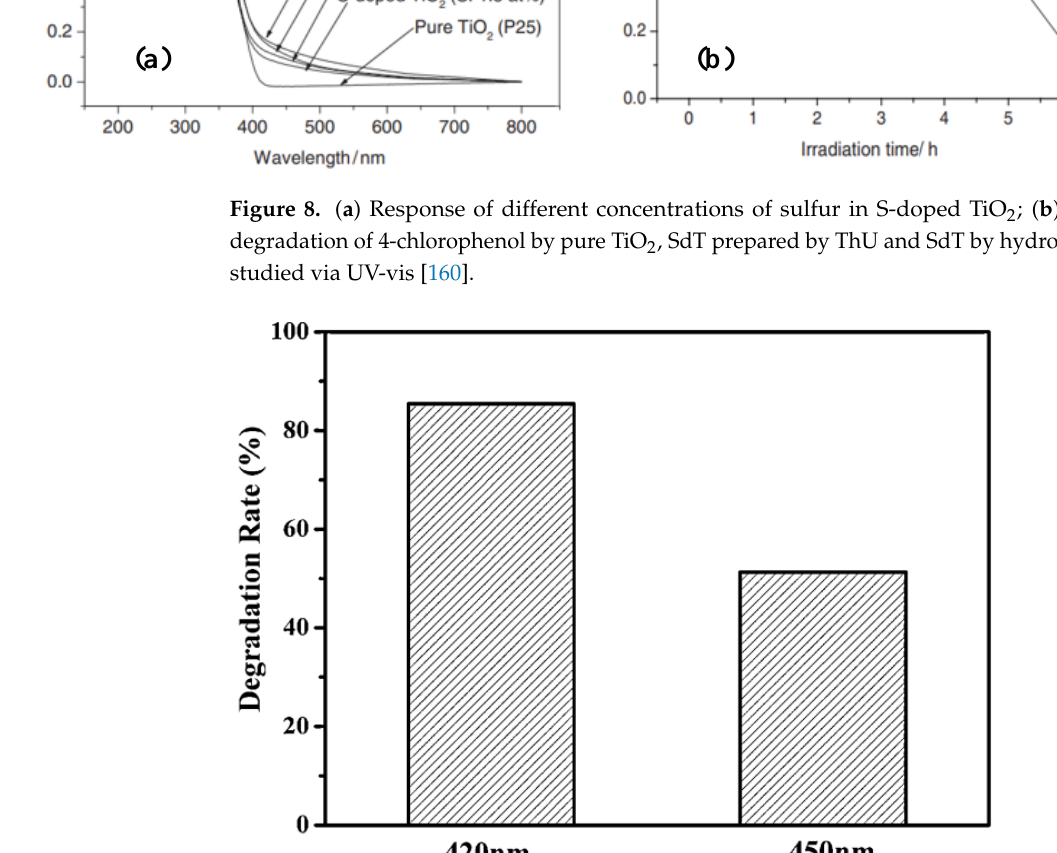
Figure 8. ( a ) Response of different concentrations of sulfur in S-doped TiO 2 ; ( b ) photocatalytic degradation of 4-chlorophenol by pure TiO 2 , SdT prepared by ThU and SdT by hydrothermal process studied via UV-vis [160].